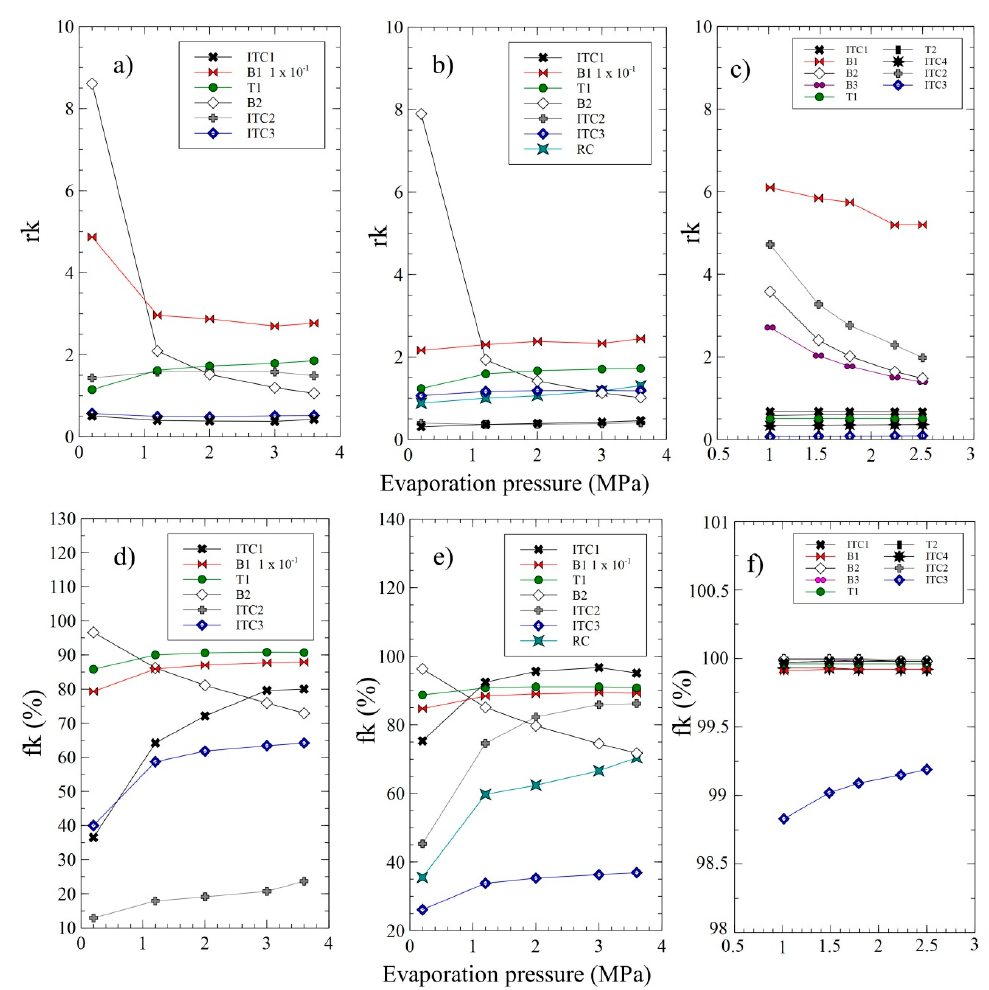
Figure 5. E ff ect of evaporation pressure on relative cost di ff erence and exergoeconomic factor per Figure 5. Effect of evaporation pressure on relative cost difference and exergoeconomic factor per component, ( a – d ) SORC, ( b – e ) RORC, and ( c – f ) component, ( a – d ) SORC, ( b – e ) RORC, and ( c – f ) DORC.